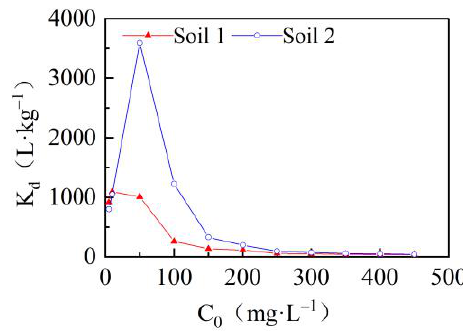
Figure 4. Relationship between the solid/liquid distribution coefficient K d and the initial concentra- tion of cadmium C 0 in two soils. tion of cadmium C 0 in two